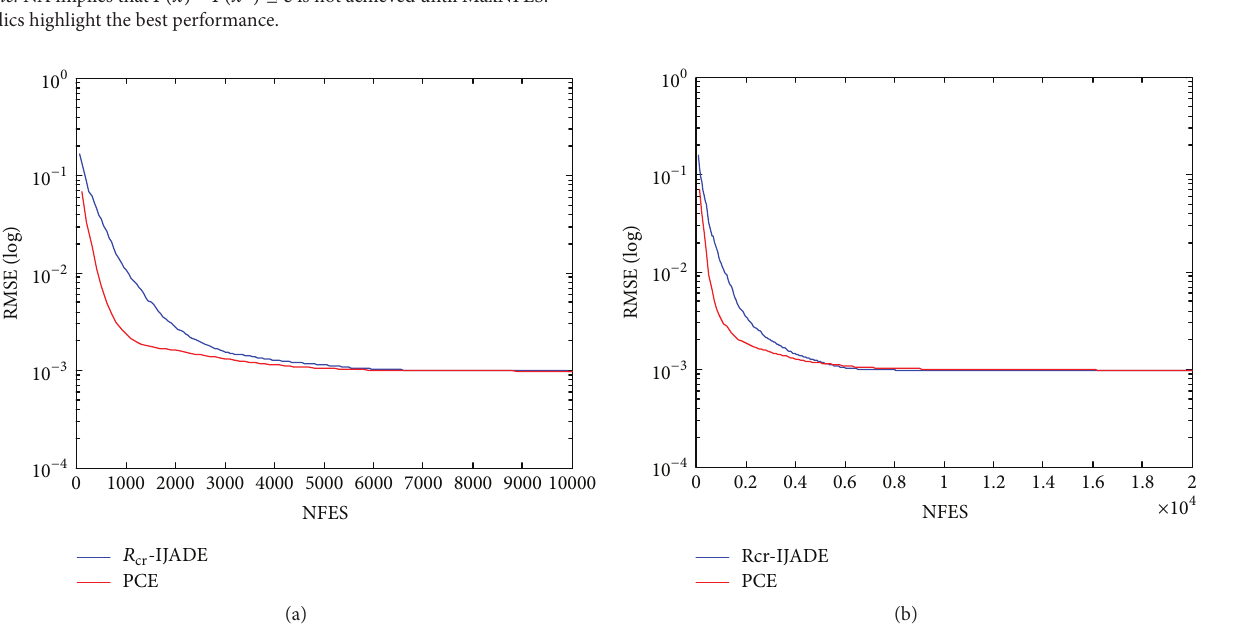
Figure 5: The convergence graphs of different EAs for (a) the single diode model and (b) the double diode